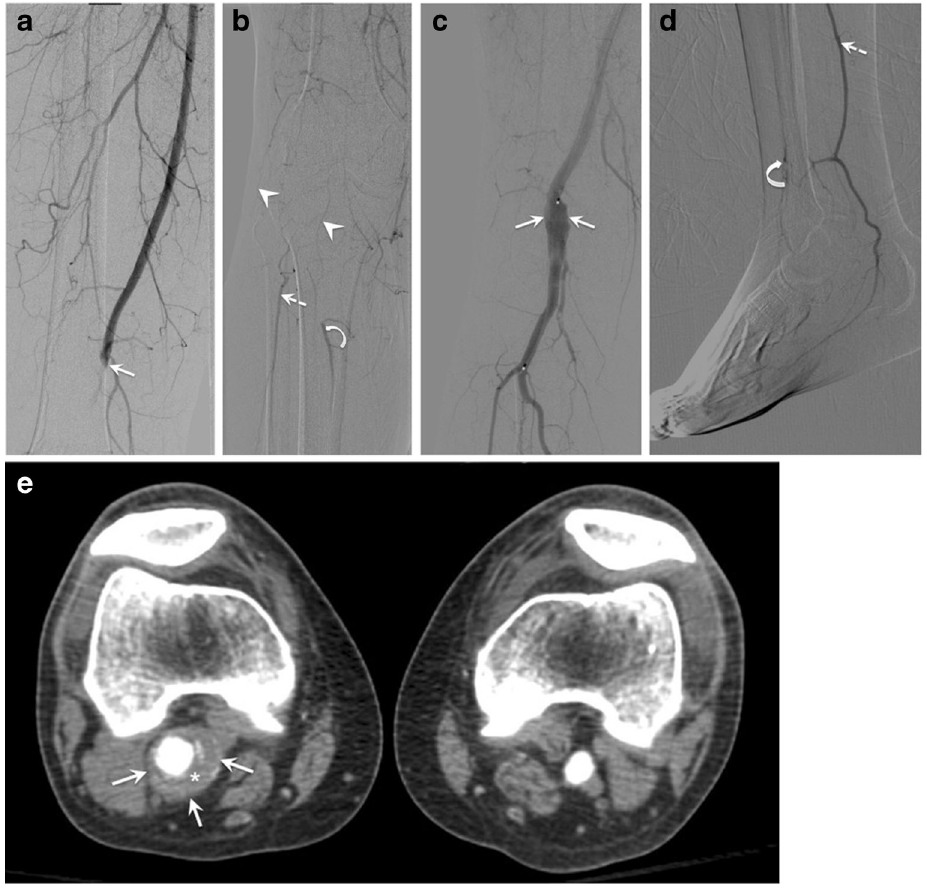
treatment. ( c , d ) Digital subtraction angiography at 22 h post-lysis reveals a large PAA( solidarrows ), withre-permeabilization oftheposterior